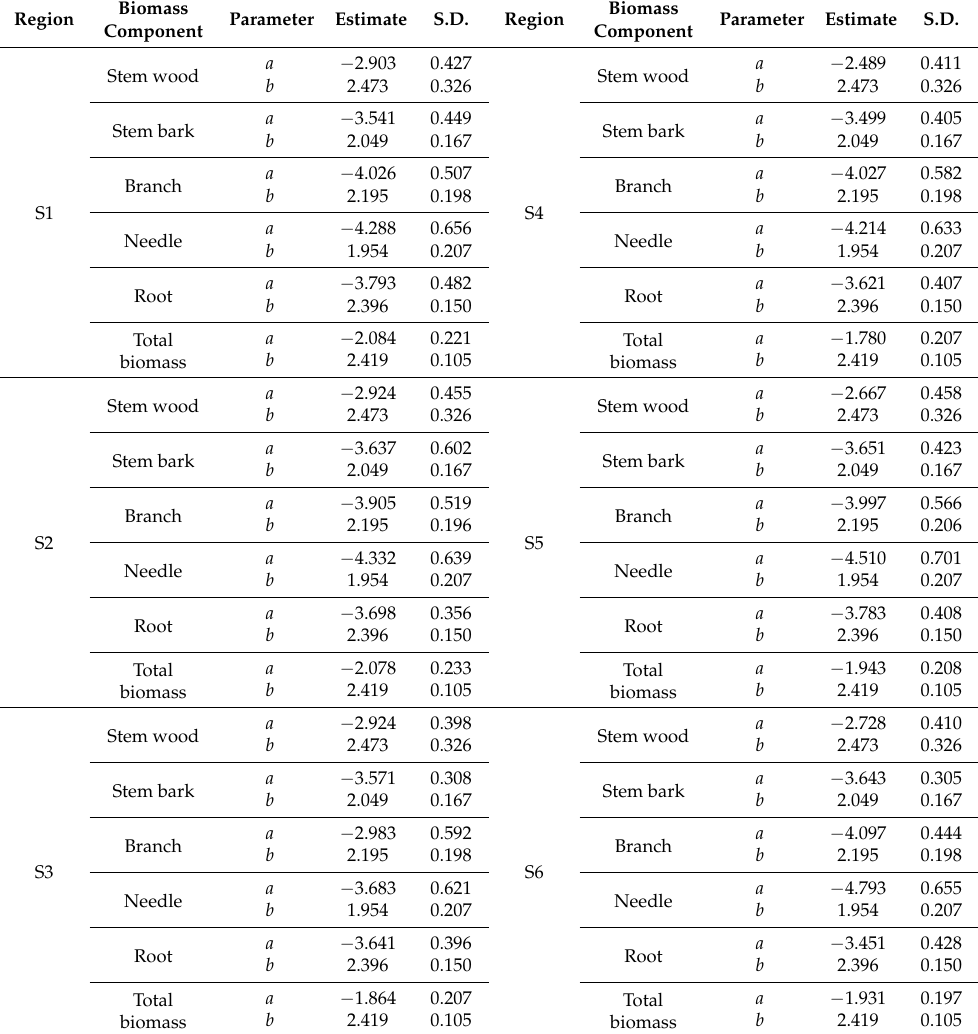
Table 4. Parameter estimates of the dummy variable model(Equation (3)).